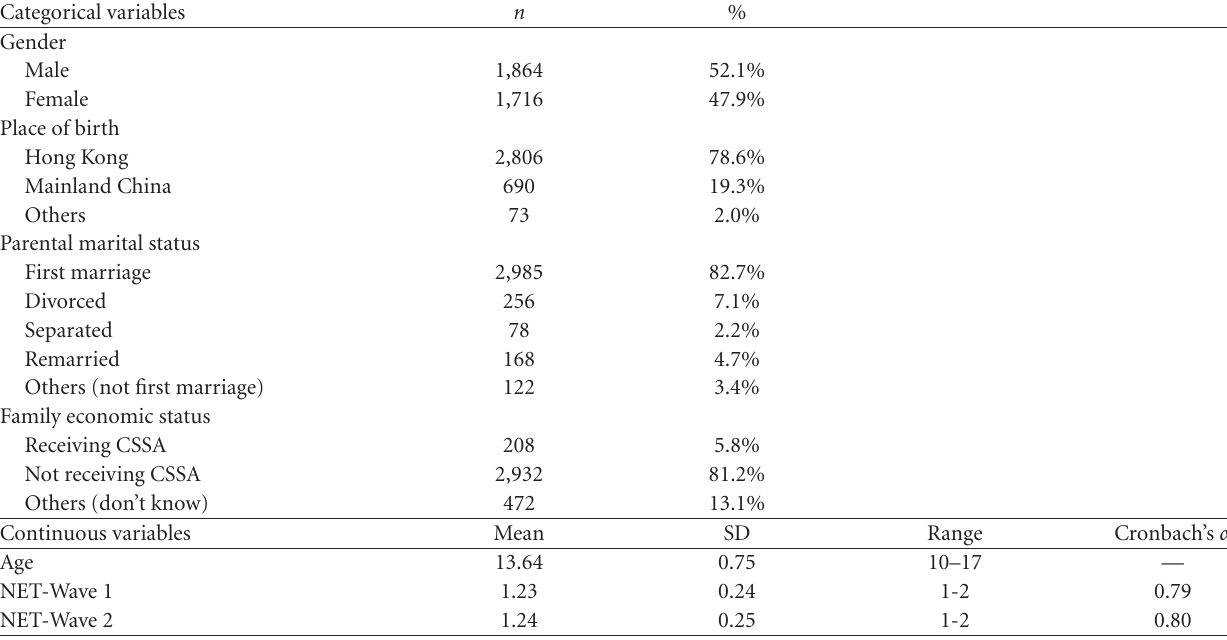
Table 1: Descriptive statistics about